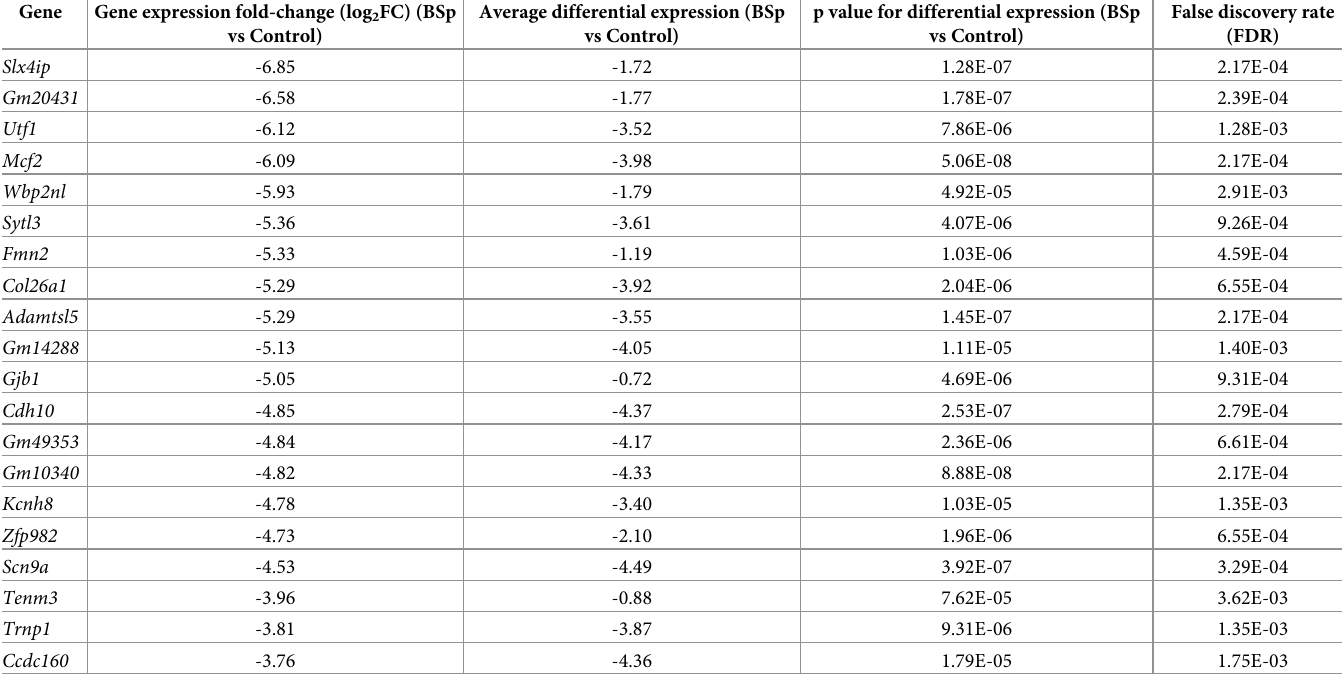
Table 2. Top 20 differentially down-regulated target genes in the offspring with maternal BSp treatment (ranked by the statistical significance). Average differential expression (BSp Gene Gene expression fold-change (log 2 FC) (BSp vs Control) vs